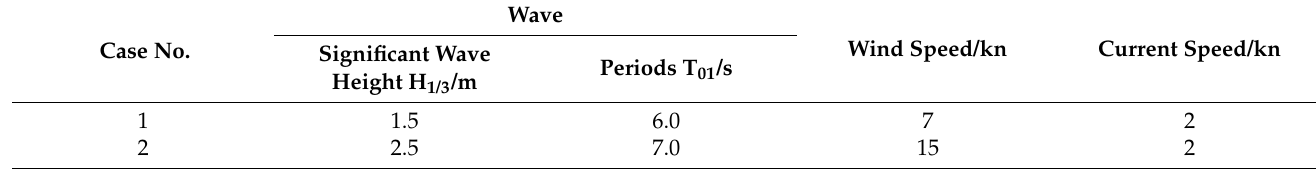
Table 2. Marine environmental parameters.